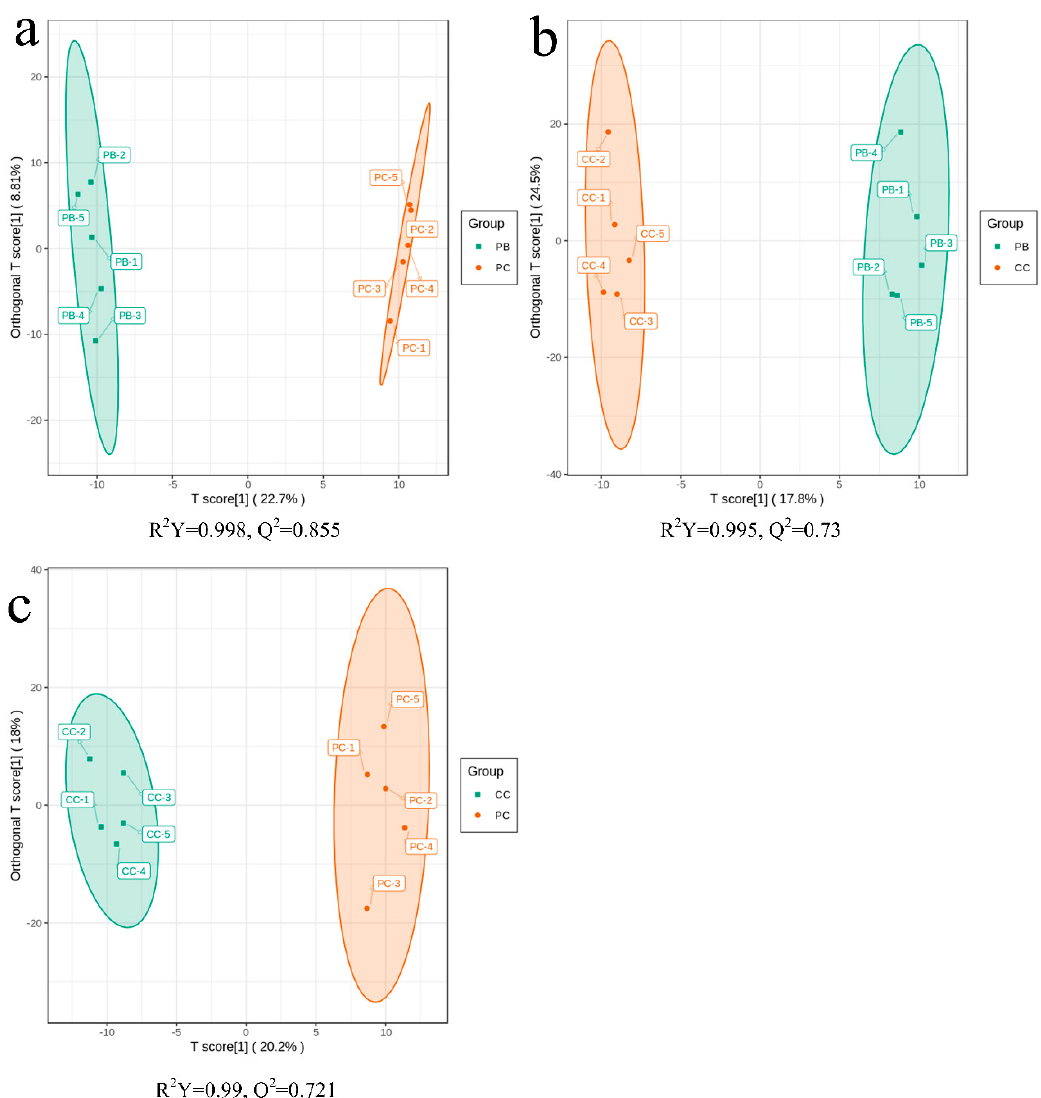
Figure 2. Score plots of orthogonal partial least squares discriminant analysis (OPLS-DA): ( a ) PB vs. PC; ( b ) PB vs. CC; ( c ) PC vs. CC. R 2 Y is the interpretation rate of the model to the Y matrix (Class label) and Q 2 the predictive ability of the model. The model is valid when Q 2 > 0.5. The X -axis is the predictive principal component, and the Y -axis is the orthogonal principal component.